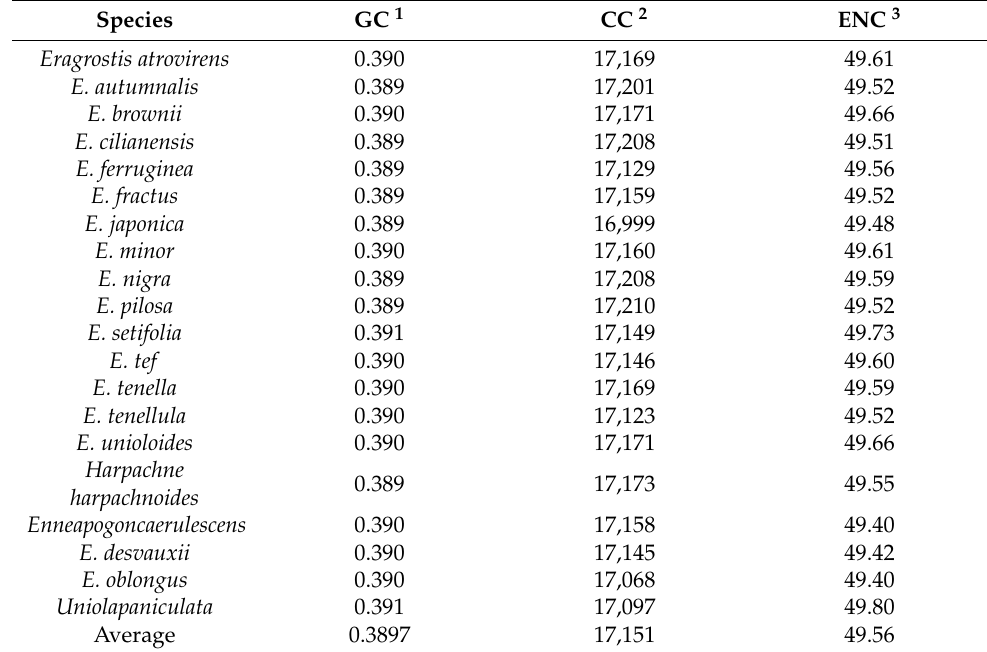
Table 4. GC content, codons count, and effective number of codons (ENC) of protein-coding genes in 20 Eragrostideae chloroplast genomes.